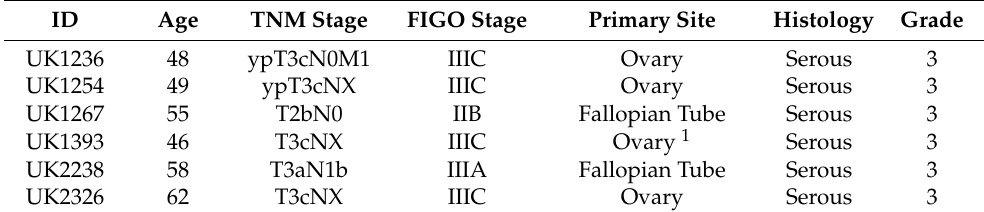
Table 1. Demographic characteristics of included subjects.